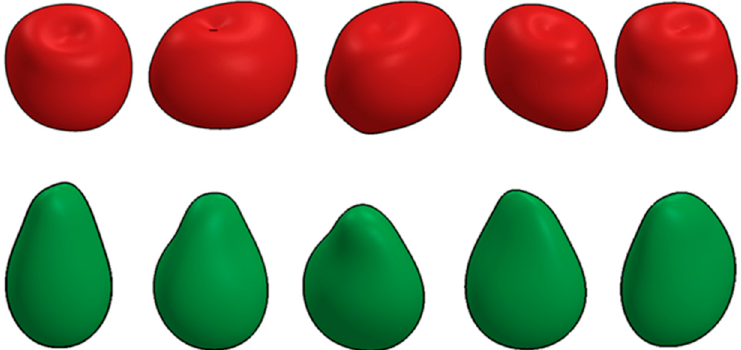
Figure 2. Digital representations for five of the profiles of tomatoes and avocadoes that were produced using the templates given in Figure 1 and Solidworks TM .